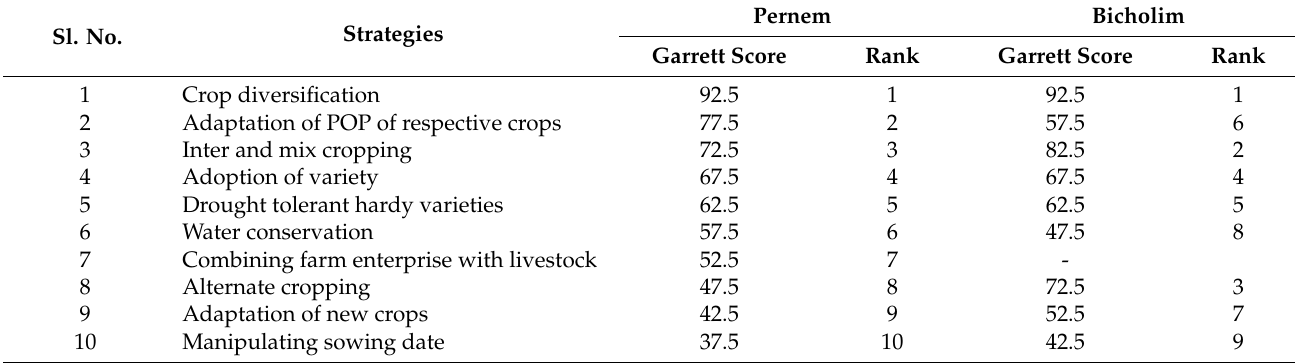
Table 2. Farm management strategies practiced by farmers.